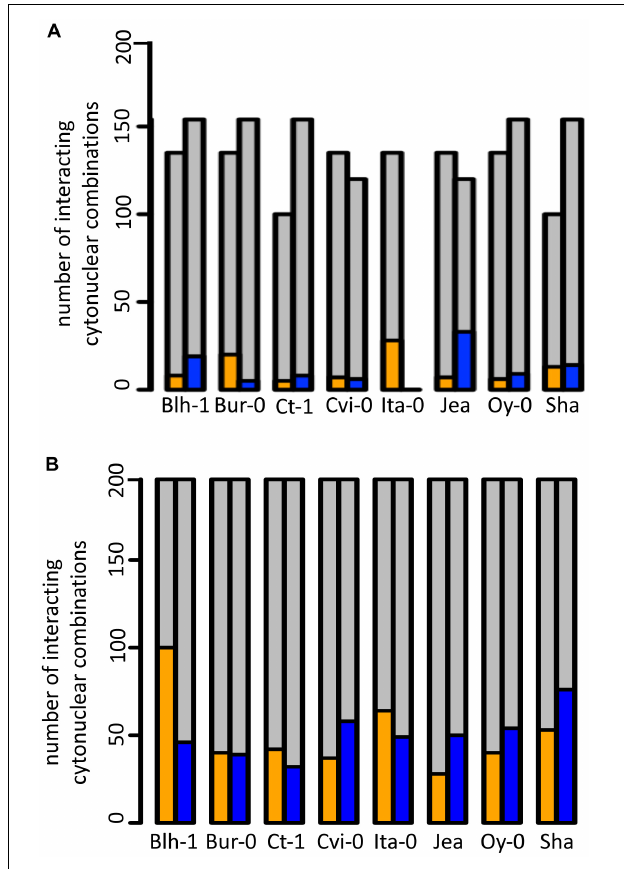
FIGURE 3 | Contribution of individual accessions to cytonuclear interacting combinations impacting germination traits. Cytonuclear interacting combinations are plotted according to the contribution of individual accessions. For each accession, the number of combinations involving its cytoplasm (orange) or its nucleus (blue) that significantly impacted dormancy depth at the four PH times (A) or germination performance after storage (B) are indicated upon the total number of tested cytonuclear interacting combinations